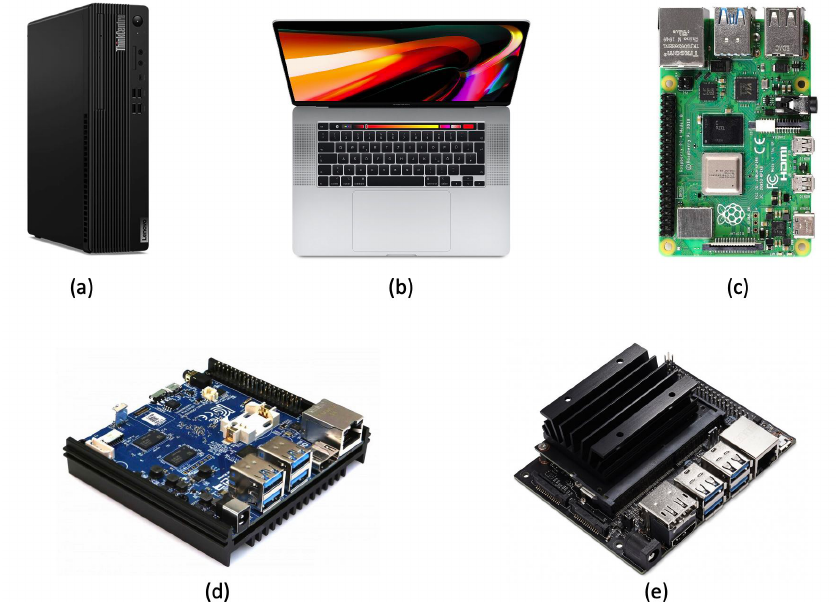
Figure 3. Elaboration units (Lenovo ThinkCentre ( a ), Apple MacBook Pro ( b ), Raspberry Pi 4 Model B ( c ), Odroid N2+ ( d ), and Jetson Nano ( e )) for processing and estimation of the